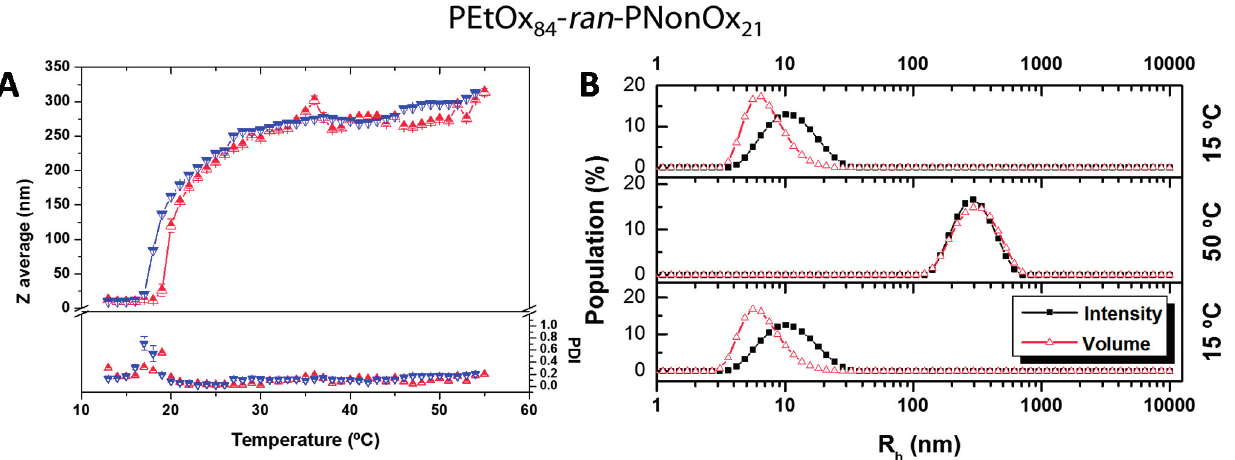
Figure 5. Temperature-dependent Dynamic Light Scattering (DLS) data for a 5 mg·mL − 1 solution of P[(EtOx) 84 - ran -(NonOx) 21 ] and 1.0 equivalent of α CD (relative to nonyl